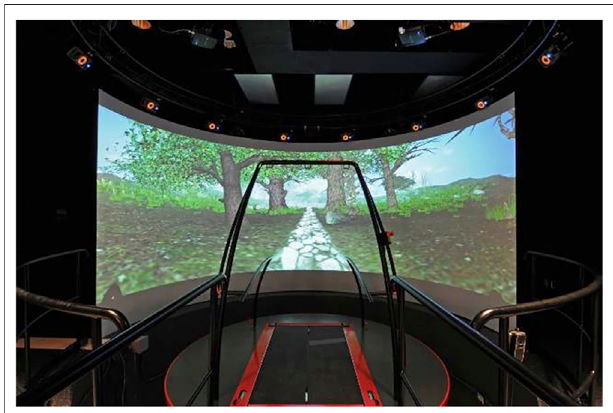
FIGURE 1 | Represents the virtual park scenario within the CAREN- Extended System (Motek Medical, Amsterdam, NL). The system includes an instrumented dual-belt treadmill as well as 12 Vicon cameras.